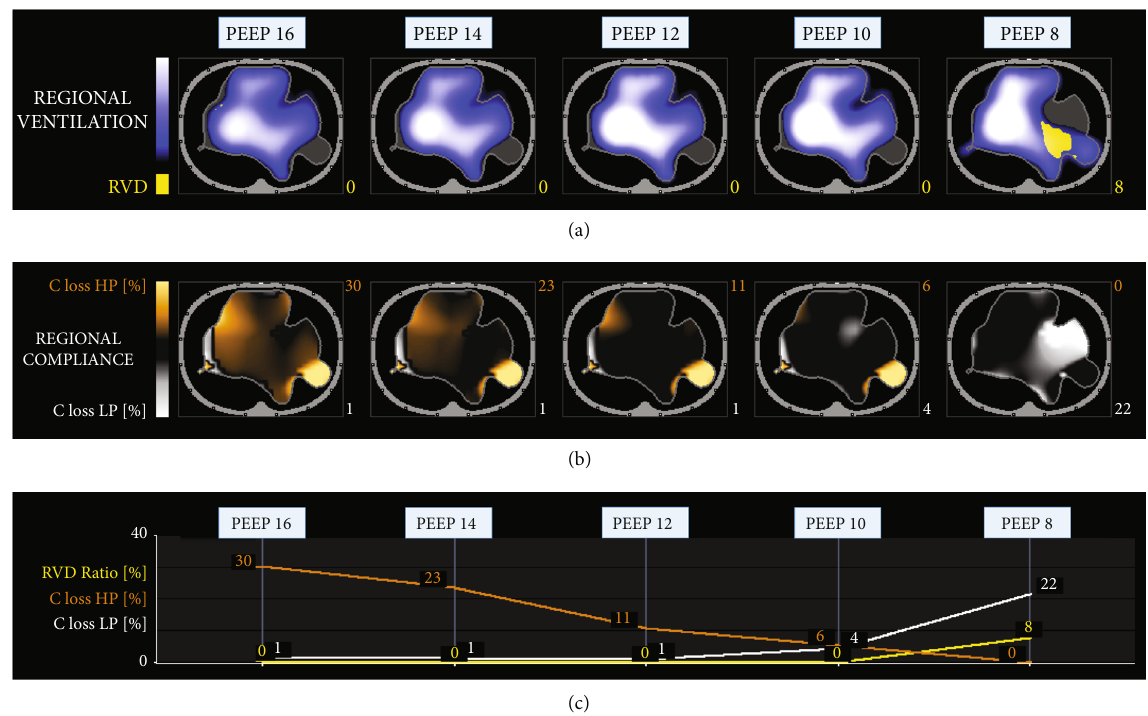
Figure 2: Electrical impedance tomography decremental positive end-expiratory pressure (PEEP) trial during the fi rst extracorporeal membrane oxygenation support. In (a), the regional distribution of tidal ventilation at di ff erent PEEP values is shown by the blue – white gradient area, while the yellow area represents regional ventilation delay (RVD), whose percentage is indicated by the yellow number. In (b), regional compliance (C) is analyzed at di ff erent PEEP values. Compliance loss secondary to high PEEP (HP) is represented by the orange area (i.e., lung overdistension), while compliance loss due to low PEEP (LP) is represented by the white area (i.e., lung collapse). The percentage amounts of compliance loss associated with HP and LP are quanti fi ed by the orange and white numbers, respectively. In (c), RVD and compliance loss due to HP and LP at the di ff erent values of PEEP are plotted in order to facilitate the selection of the patient ’ s best PEEP. This electrical impedance analysis shows the extreme heterogeneity of ventilation distribution, re fl ecting the severe and di ff use lung parenchyma abnormalities, documented also by chest computed